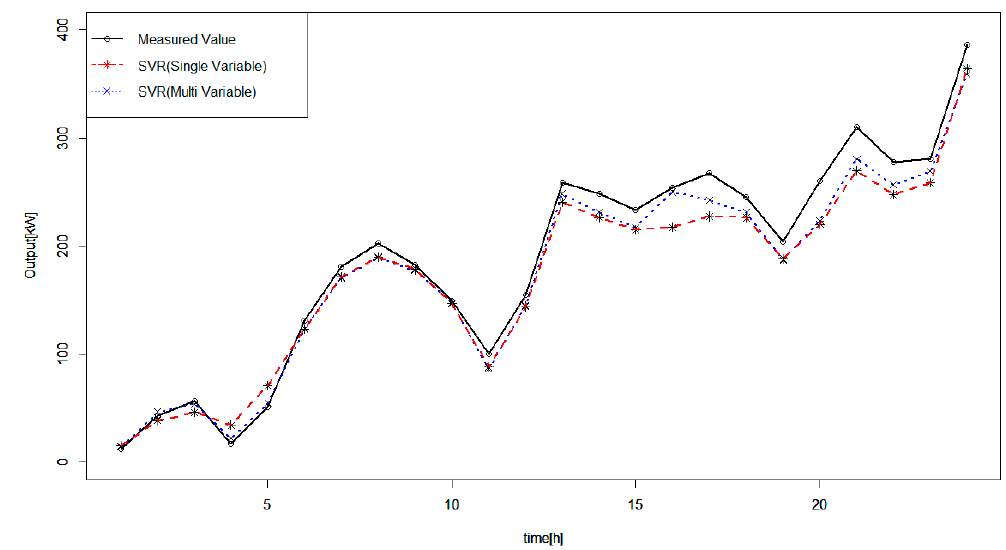
Figure 6. Measured and forecasted wind power outputs on 11 January 2016.